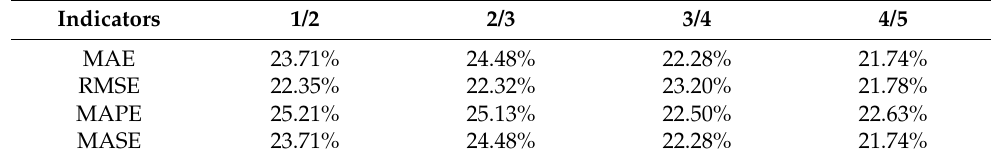
Table 3. Relative reduction of each indicator of MP-SAX-STM compared with STM of Set #2. Indicators 1/2 2/3 3/4